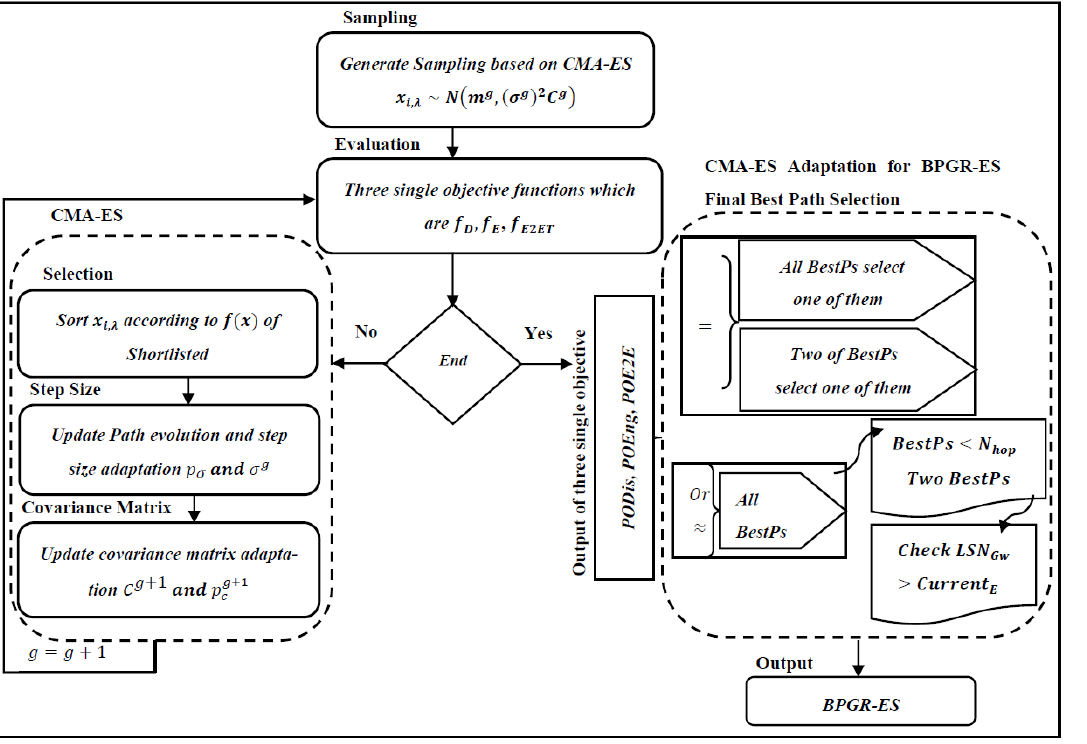
Figure 1. Schematic view of proposed Graph Routing model.